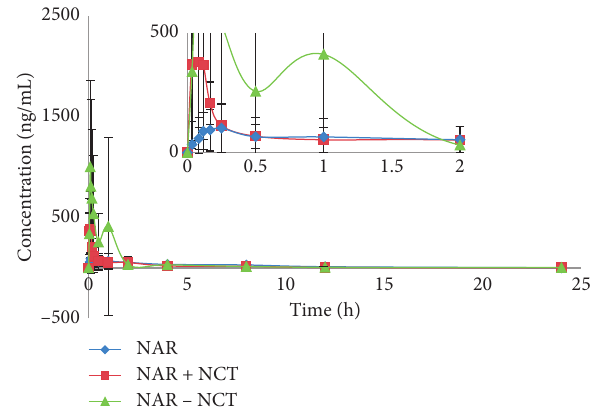
Figure 7: Drug concentration-time curve (in terms of NAR 30mg/ kg) ( n �